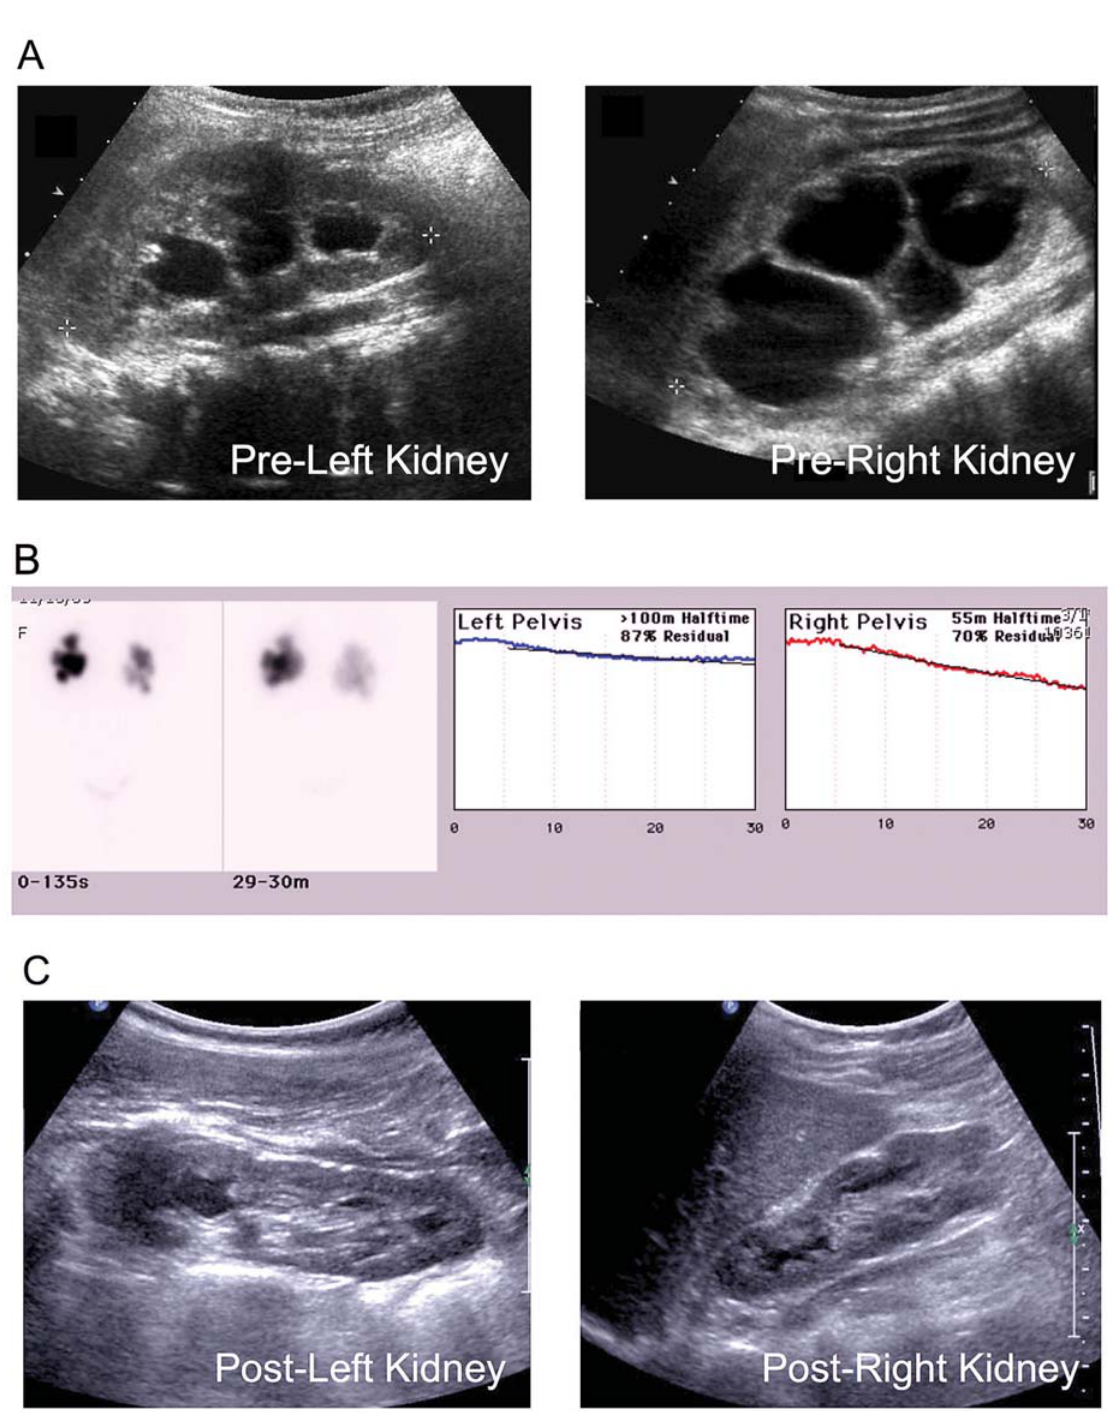
Figure 3 – (cid:3)(cid:56)(cid:79)(cid:87)(cid:85)(cid:68)(cid:86)(cid:82)(cid:88)(cid:81)(cid:71)(cid:3)(cid:191)(cid:81)(cid:71)(cid:76)(cid:81)(cid:74)(cid:86)(cid:17)(cid:3)(cid:36)(cid:12)(cid:3)(cid:51)(cid:85)(cid:72)(cid:82)(cid:83)(cid:72)(cid:85)(cid:68)(cid:87)(cid:76)(cid:89)(cid:72)(cid:3)(cid:88)(cid:79)(cid:87)(cid:85)(cid:68)(cid:86)(cid:82)(cid:88)(cid:81)(cid:71)(cid:3)(cid:85)(cid:72)(cid:89)(cid:72)(cid:68)(cid:79)(cid:86)(cid:3)(cid:80)(cid:82)(cid:71)(cid:72)(cid:85)(cid:68)(cid:87)(cid:72)(cid:3)(cid:75)(cid:92)(cid:71)(cid:85)(cid:82)(cid:81)(cid:72)(cid:83)(cid:75)(cid:85)(cid:82)(cid:86)(cid:76)(cid:86)(cid:3)(cid:82)(cid:73)(cid:3)(cid:87)(cid:75)(cid:72)(cid:3)(cid:79)(cid:72)(cid:73)(cid:87)(cid:3)(cid:68)(cid:81)(cid:71)(cid:3)(cid:86)(cid:72)(cid:89)(cid:72)(cid:85)(cid:72)(cid:3)(cid:75)(cid:92)(cid:71)(cid:85)(cid:82)(cid:81)(cid:72)(cid:83)(cid:75)(cid:85)(cid:82)(cid:86)(cid:76)(cid:86)(cid:3)(cid:82)(cid:73)(cid:3) (cid:87)(cid:75)(cid:72)(cid:3)(cid:85)(cid:76)(cid:74)(cid:75)(cid:87)(cid:3)(cid:78)(cid:76)(cid:71)(cid:81)(cid:72)(cid:92)(cid:17)(cid:3)(cid:37)(cid:12)(cid:3)(cid:51)(cid:85)(cid:72)(cid:82)(cid:83)(cid:72)(cid:85)(cid:68)(cid:87)(cid:76)(cid:89)(cid:72)(cid:3)(cid:71)(cid:76)(cid:88)(cid:85)(cid:72)(cid:87)(cid:76)(cid:70)(cid:3)(cid:48)(cid:36)(cid:42)(cid:16)(cid:22)(cid:3)(cid:85)(cid:72)(cid:81)(cid:82)(cid:74)(cid:85)(cid:68)(cid:80)(cid:3)(cid:71)(cid:72)(cid:80)(cid:82)(cid:81)(cid:86)(cid:87)(cid:85)(cid:68)(cid:87)(cid:76)(cid:81)(cid:74)(cid:3)(cid:86)(cid:76)(cid:74)(cid:81)(cid:76)(cid:191)(cid:70)(cid:68)(cid:81)(cid:87)(cid:3)(cid:85)(cid:72)(cid:86)(cid:76)(cid:71)(cid:88)(cid:68)(cid:79)(cid:3)(cid:82)(cid:73)(cid:3)(cid:87)(cid:75)(cid:72)(cid:3)(cid:85)(cid:68)(cid:71)(cid:76)(cid:82)(cid:81)(cid:88)(cid:70)(cid:79)(cid:76)(cid:71)(cid:72)(cid:3)(cid:76)(cid:81)(cid:3)(cid:69)(cid:82)(cid:87)(cid:75)(cid:3)(cid:78)(cid:76)(cid:71)(cid:81)(cid:72)(cid:92)(cid:86)(cid:3)(cid:68)(cid:73)(cid:87)(cid:72)(cid:85)(cid:3) (cid:73)(cid:88)(cid:85)(cid:82)(cid:86)(cid:72)(cid:80)(cid:76)(cid:71)(cid:72)(cid:3)(cid:68)(cid:71)(cid:80)(cid:76)(cid:81)(cid:76)(cid:86)(cid:87)(cid:85)(cid:68)(cid:87)(cid:76)(cid:82)(cid:81)(cid:17)(cid:3)(cid:38)(cid:12)(cid:3)(cid:51)(cid:82)(cid:86)(cid:87)(cid:82)(cid:83)(cid:72)(cid:85)(cid:68)(cid:87)(cid:76)(cid:89)(cid:72)(cid:3)(cid:88)(cid:79)(cid:87)(cid:85)(cid:68)(cid:86)(cid:82)(cid:88)(cid:81)(cid:71)(cid:3)(cid:71)(cid:72)(cid:80)(cid:82)(cid:81)(cid:86)(cid:87)(cid:85)(cid:68)(cid:87)(cid:72)(cid:86)(cid:3)(cid:81)(cid:82)(cid:3)(cid:75)(cid:92)(cid:71)(cid:85)(cid:82)(cid:81)(cid:72)(cid:83)(cid:75)(cid:85)(cid:82)(cid:86)(cid:76)(cid:86)(cid:3)(cid:76)(cid:81)(cid:3)(cid:87)(cid:75)(cid:72)(cid:3)(cid:85)(cid:76)(cid:74)(cid:75)(cid:87)(cid:3)(cid:78)(cid:76)(cid:71)(cid:81)(cid:72)(cid:92)(cid:3)(cid:68)(cid:81)(cid:71)(cid:3)(cid:80)(cid:76)(cid:81)(cid:76)(cid:80)(cid:68)(cid:79)(cid:3)(cid:83)(cid:72)(cid:79)(cid:89)(cid:76)(cid:70)(cid:68)(cid:79)(cid:76)(cid:72)(cid:70)(cid:87)(cid:68)(cid:86)(cid:76)(cid:86)(cid:3) in the left kidney 2 months after